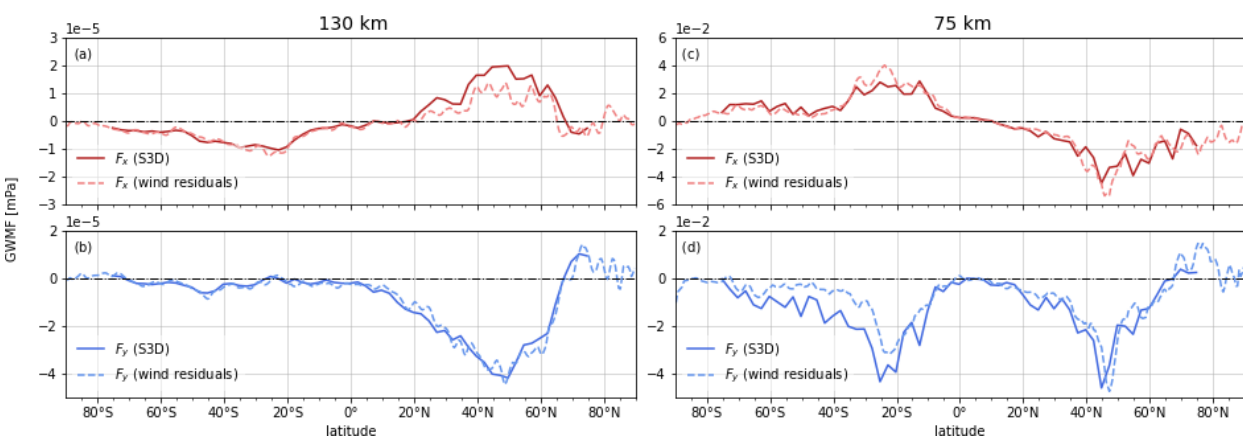
Figure 9. The zonal mean vertical flux of zonal (red) and meridional (blue) momentum. Dashed lines show GWMF calculated from wind residuals (Eq. 9), while solid lines are calculated using wave vectors and residual temperature amplitudes (Eq. 10). Panels (a) and (b) show the fluxes at 130km altitude, while panels (c) and (d) show fluxes at 75km. Wind-based fluxes have been smoothed by averaging over 4km altitude bins centered at the specified altitude and by averaging over 5 ◦ latitude bins.